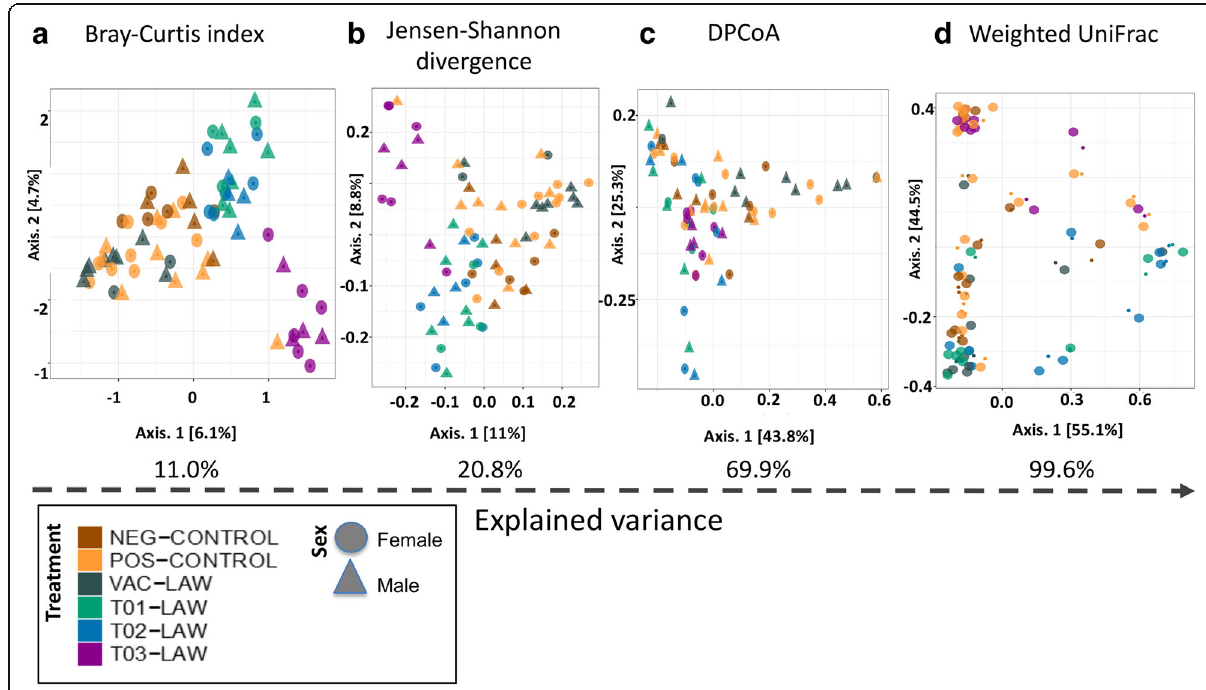
Fig. 2 Comparative analysis between beta diversity indices and treatment groups. a-c Indication of the level of clustering and how treatment groups map to gender. d The level of clustering by treatment as a proxy for how much variation is explained by treatment group